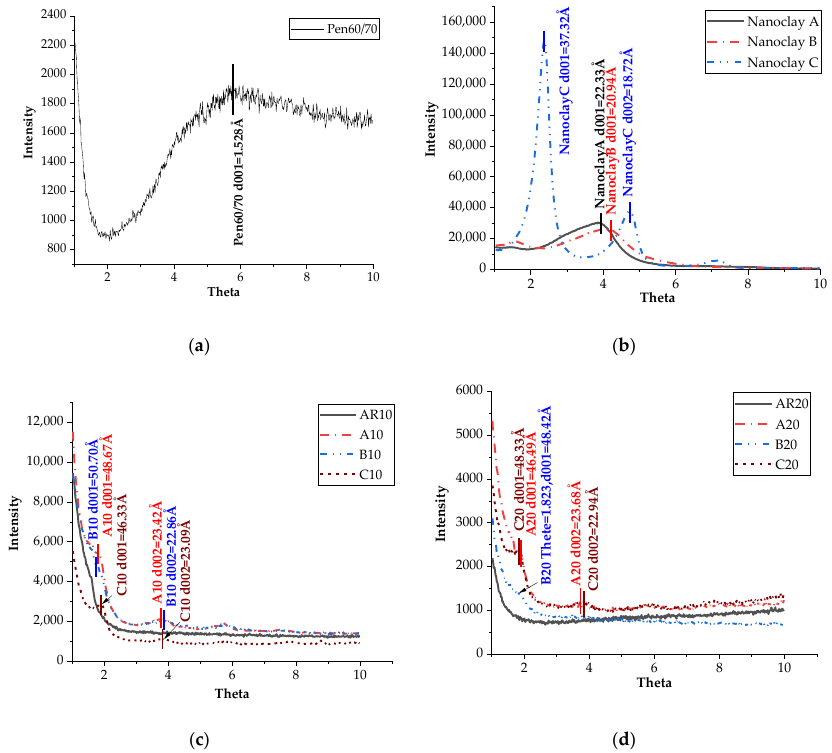
Figure 10. XRD evaluation: ( a ) neat bitumen; ( b ) nanoclay A, B and C; ( c ) ARNs with 10 wt. % CRM; ( d ) ARNs with 20 wt. % CRM Table 10. Layer distance of nanoclay before and after mixed with bitumen.